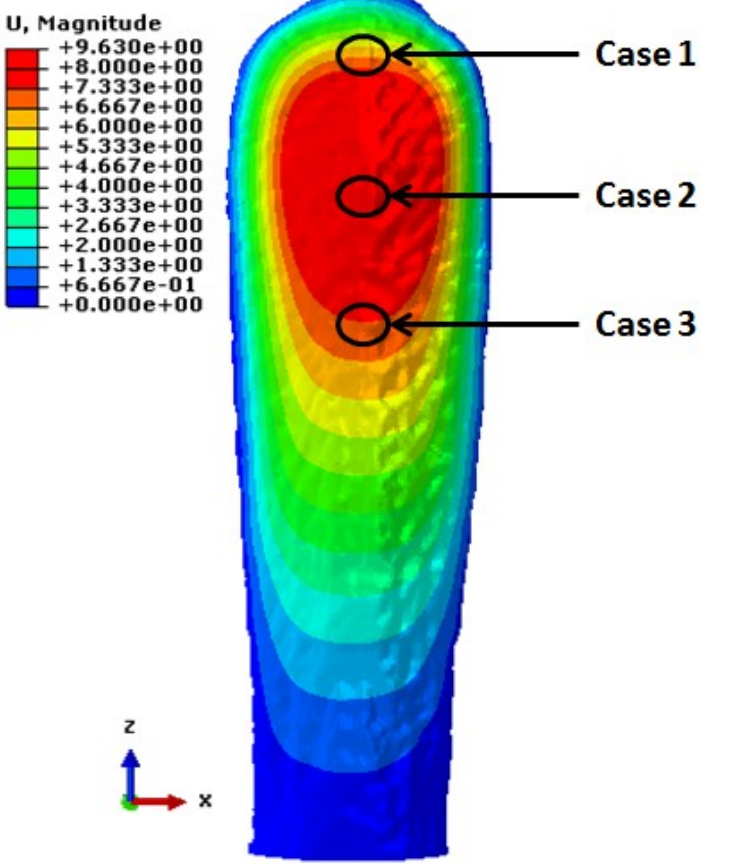
Figure 13. Displacement contours of the rostrum subjected to uniform pressure loading with a fixed plate boundary condition showing the location of source / sink. Cases 1 and 3 were chosen at the edges, and Case 2 in the center of the maximum displacement contour. Dorsal view of rostrum.